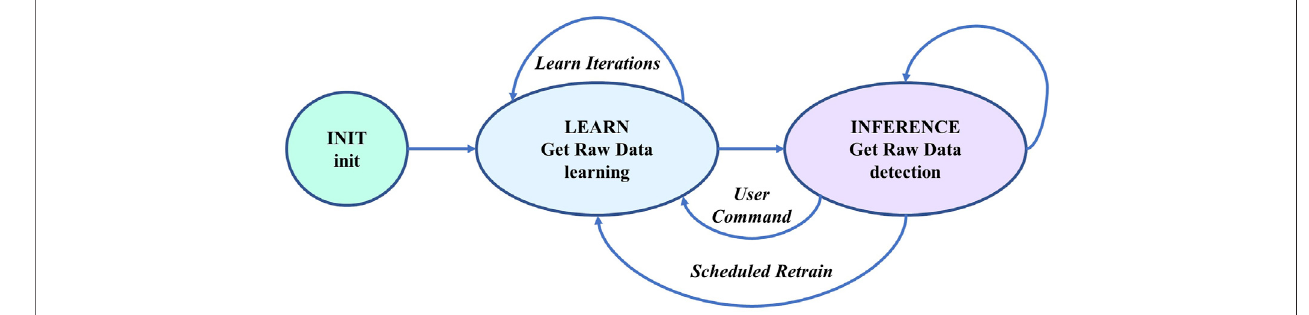
FIGURE 8 | ML model state machine diagram.